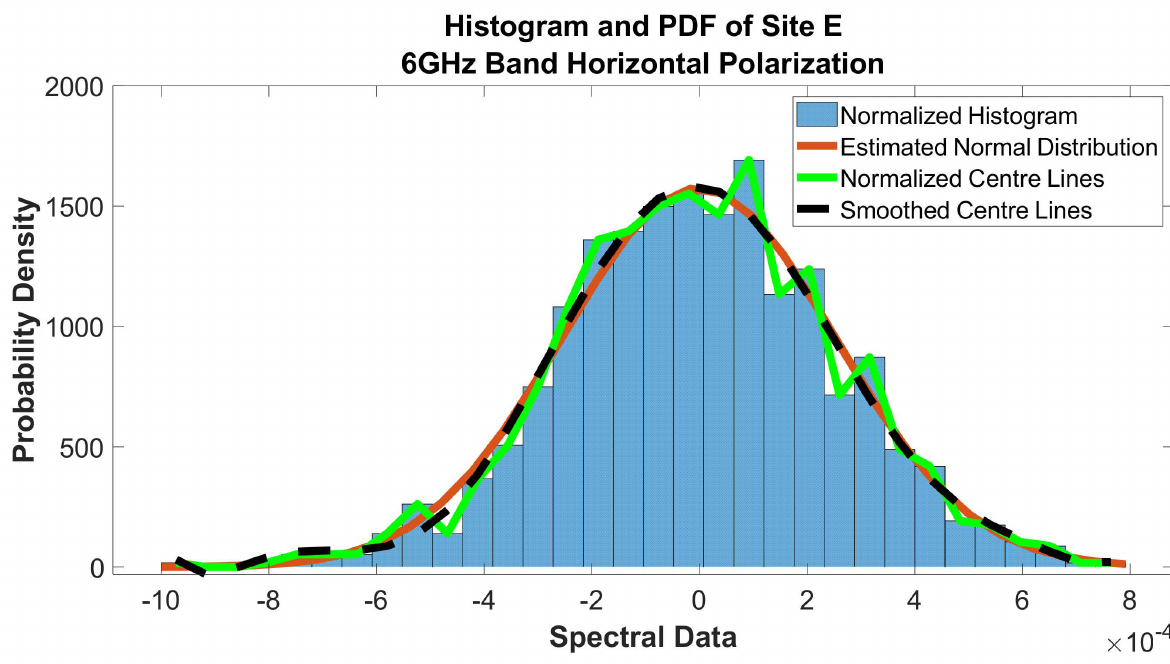
Figure 47. Histogram and PDF of site E at 6 GHz band horizontal